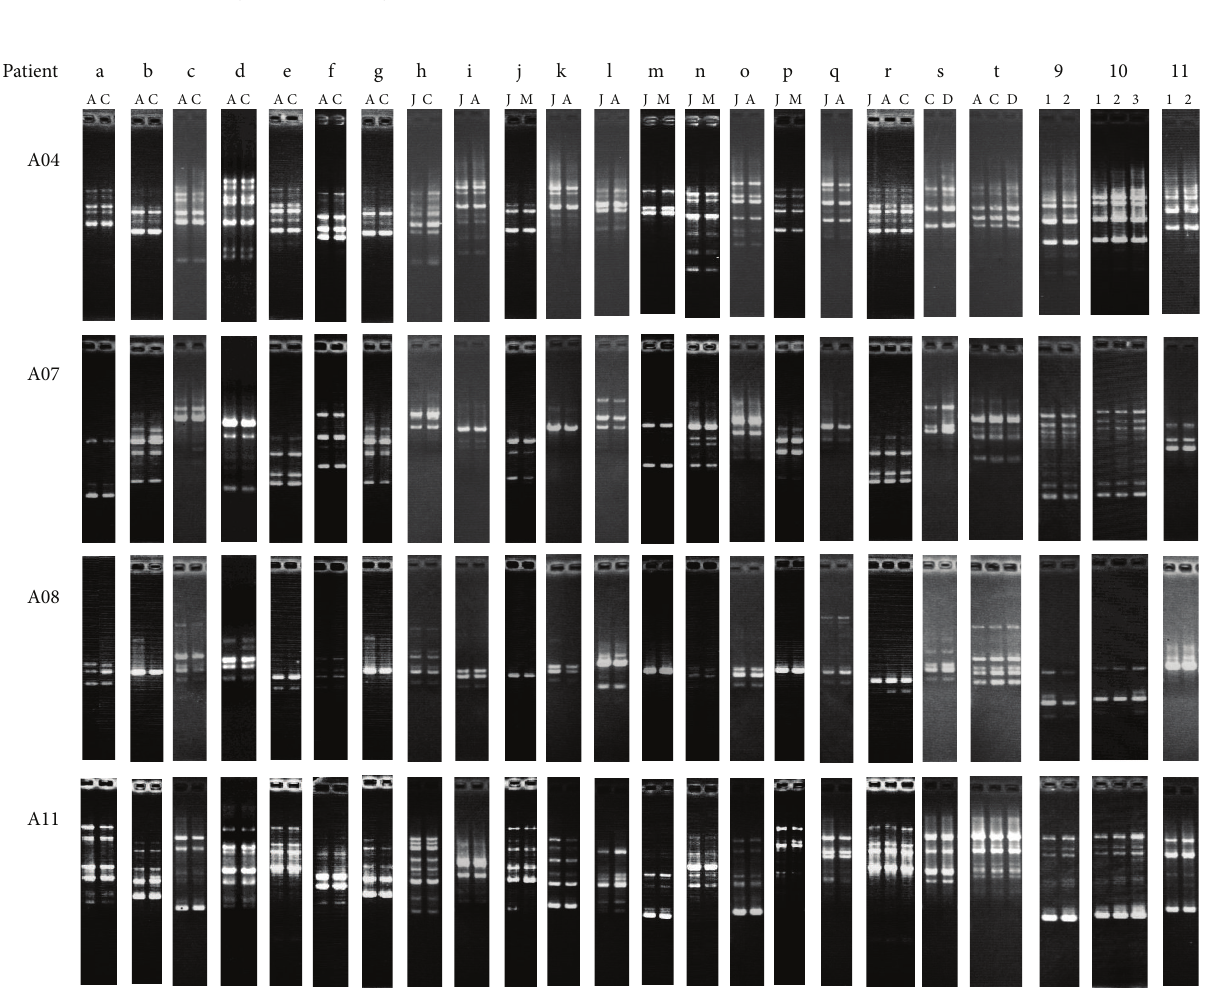
Figure 1: RAPD fingerprinting patterns of H. pylori isolates from patients (a to t in Table 1 and 9 to 11 in Table 2) obtained by RAPD analysis with primers A04, A07, A08, and A11. A: antrum, C: corpus, D: duodenum, J: gastric juice, and M: